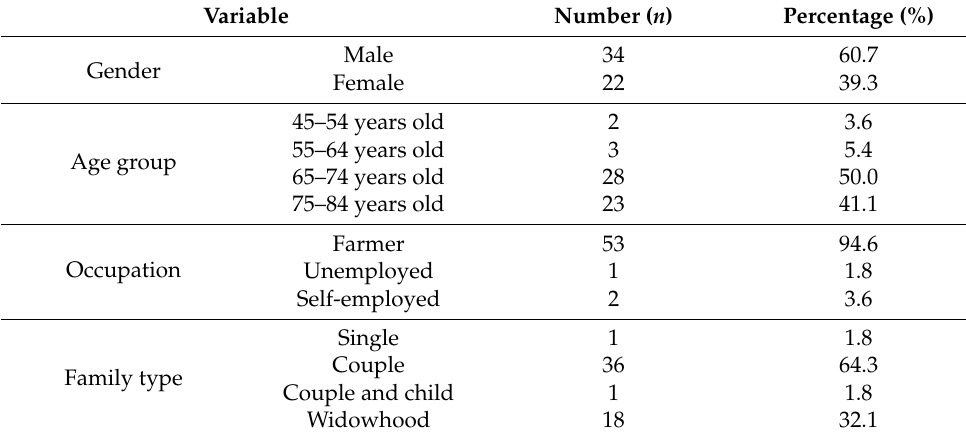
Table 1. Demographic data of respondents from each household ( n = 56).